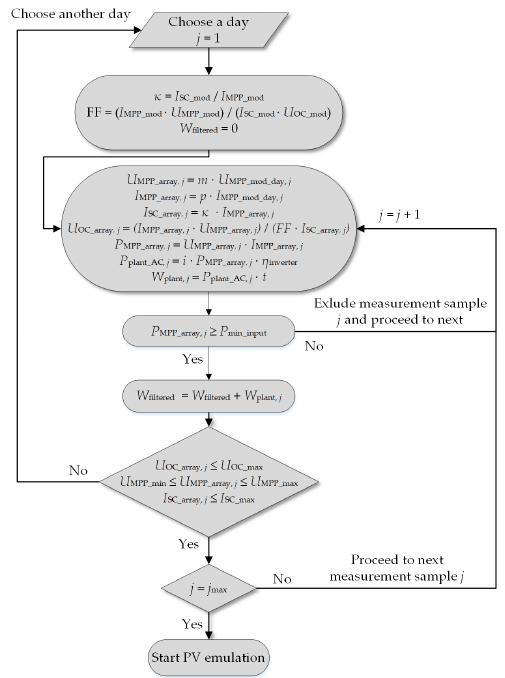
Figure 6. Flowchart of the algorithm for measurement data filtering